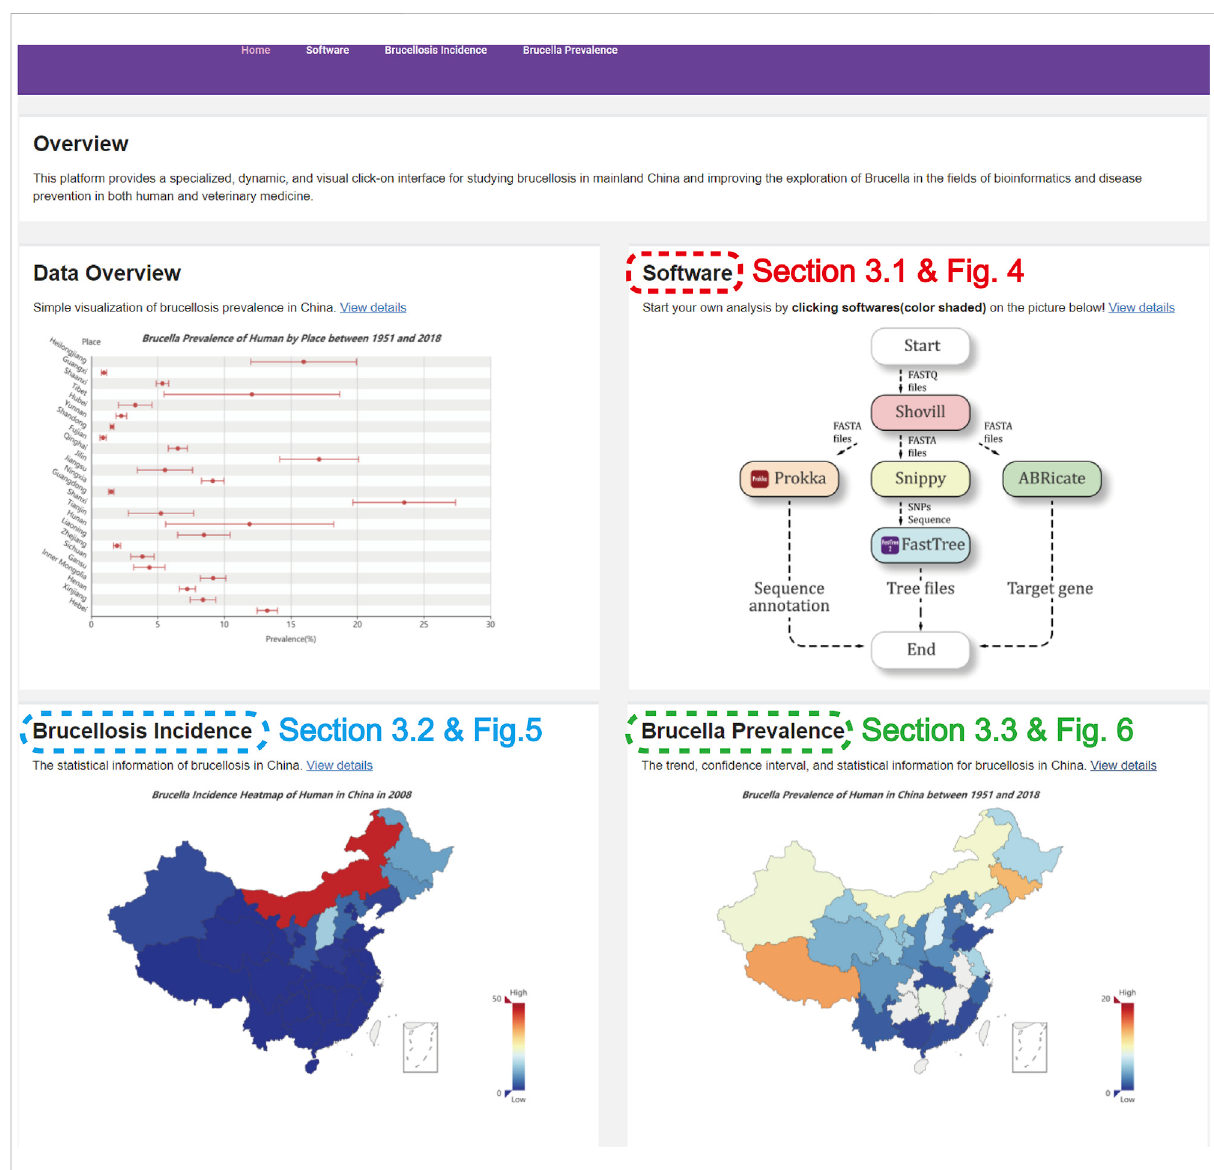
FIGURE 1 The homepage of the